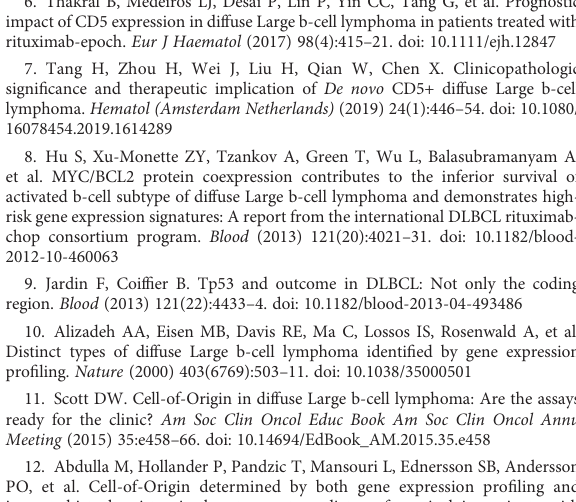
SUPPLEMENTARY FIGURE 2 Distinct prognoses between cases with different genetic subtypes by LymphGen. (A, B) Kaplan-Meier plots of OS and PFS among BN2, EZB, MCD, N1, and Other subtypes. (C, D) Kaplan-Meier plots of OS and PFS among BN2, EZB, MCD, N1, and Other subtypes in the CD5- group, or between MCD and non-MCD in the CD5+ group.